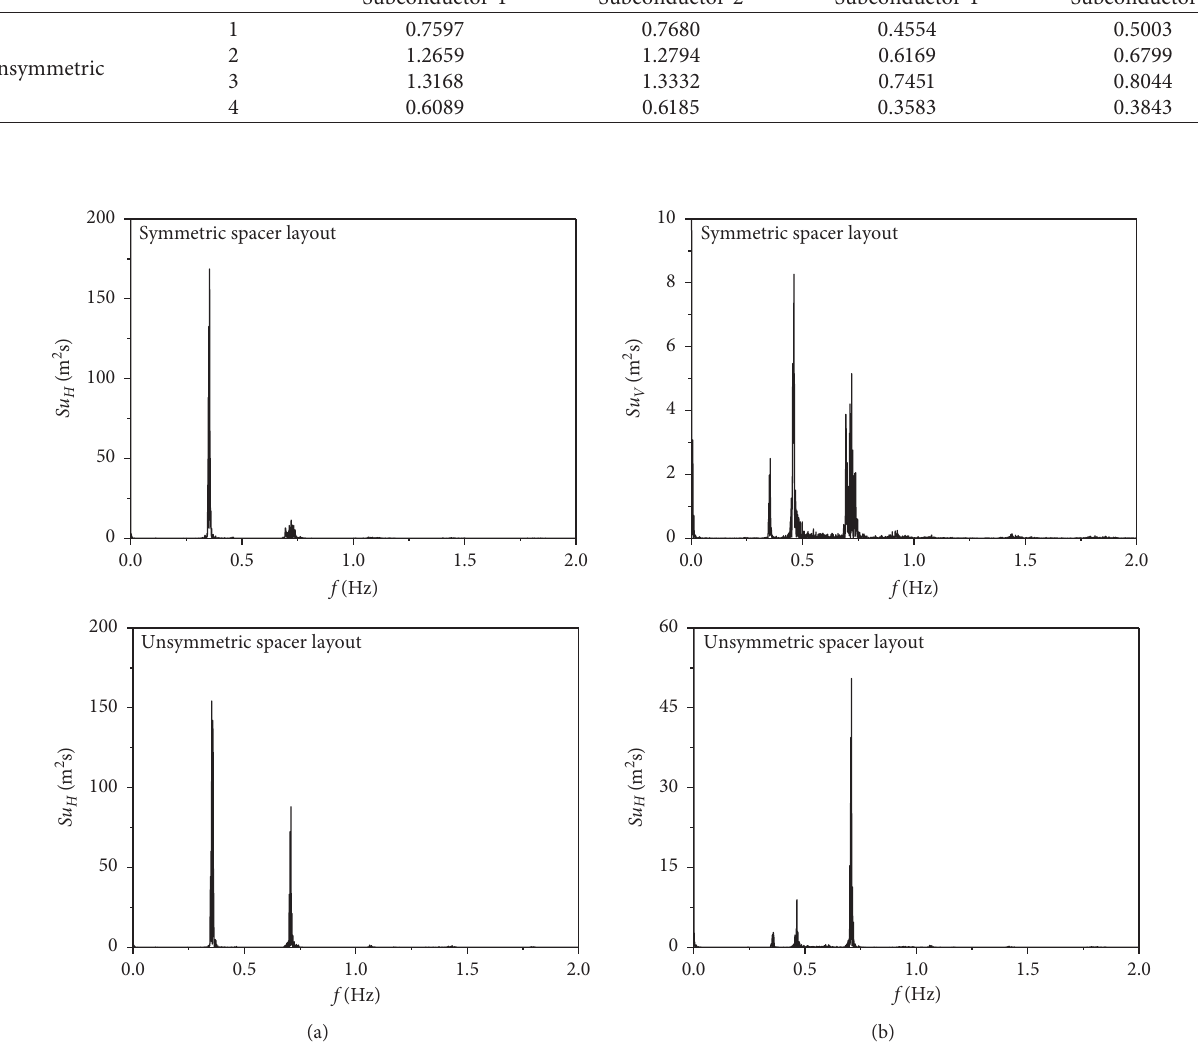
Figure 15: Displacement spectra at the subspan 3 midpoint of subconductor 1 under different current intensities ( I � 500A, α �− 35 ° ): (a) horizontal displacement and (b) vertical